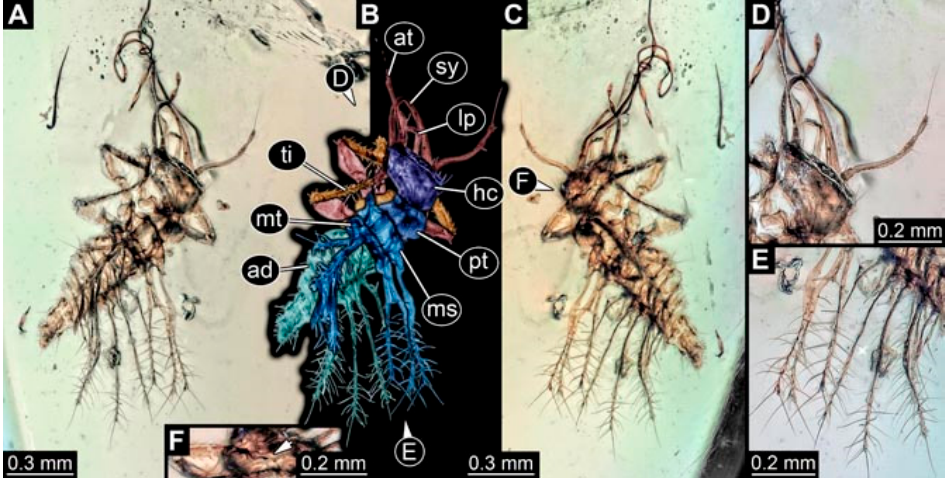
Figure 5. Specimen 4824 (BUB 3359); Myanmar amber. ( A ) Dorsal view. ( B ) Dorsal view, colour- marked. ( C ) Ventral view. ( D ) Close-up of head capsule in dorsal view. ( E ) Close-up of protrusions in ventral view. ( F ) Close-up of trunk appendage with empodium (arrows). Abbreviations: ad = ab- domen; at = antenna; hc = head capsule; lp = labial palp; ms = mesothorax; mt = metathorax; pt = prothorax; sy = stylet; ti =